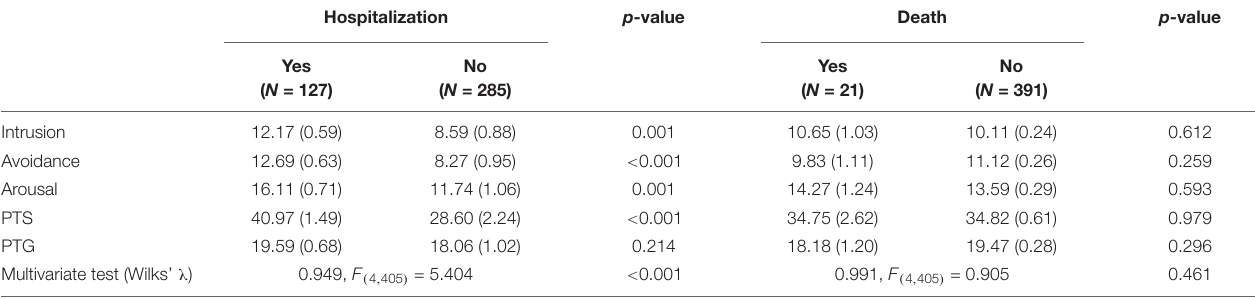
TABLE 4 | MANOVA table reporting the group difference based on direct exposure to trauma in the form of hospitalization and death. Hospitalization p- value